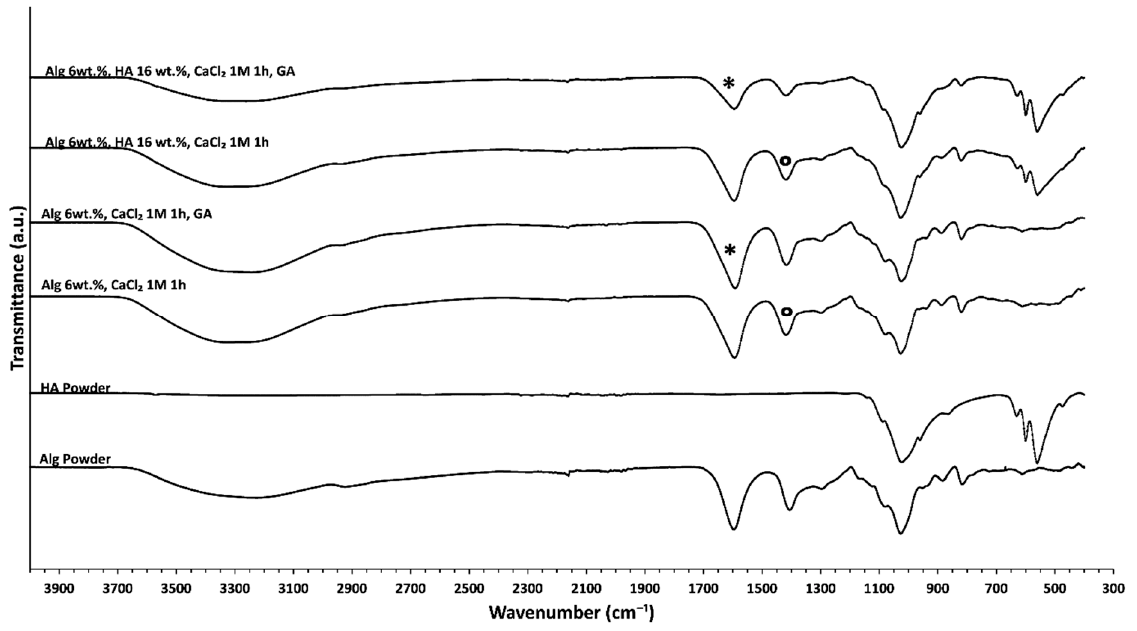
Figure 5. FTIR-ATR spectra of different alginate-HA aerogel formulations. The spectra of the raw materials (HA and Alg) are also included for the sake of comparison.